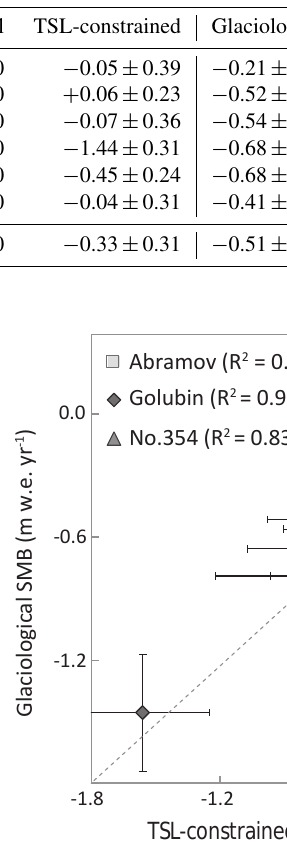
Figure 9. Comparison of modelled annual SMB constrained by TSL observations and glaciological SMB for Abramov, Golubin and Glacier no. 354. Uncertainties in the annual SMB are indicated.